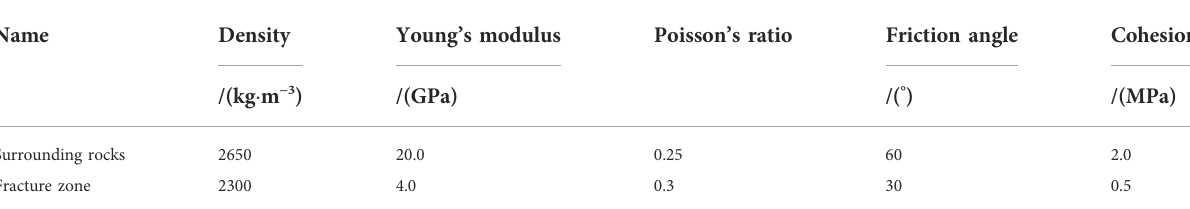
TABLE 1 Material parameters used in